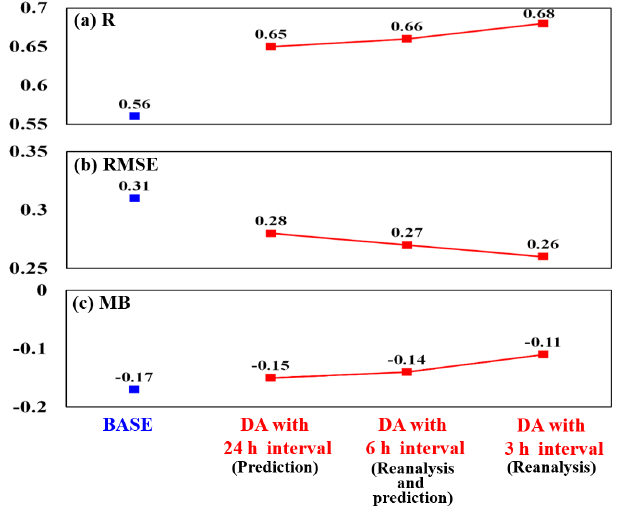
Figure 12. Variations in three performance metrics (R, RMSE and MB) with time intervals of data assimilations. For these tests, the GOCI AODs were used in the DA to update the initial condi- tions of the CMAQ model simulations. The results from the three CMAQ model simulations were compared with AERONET AODs (“ground truth”). The blue squares represent the performances from the BASE RUNs and the red squares indicate the performances from the DA RUNs. The three experiments were carried out with the as- similation time intervals of 24, 6 and 3h, respectively. Here, the DA RUN with the 24h time interval is referred to as “air quality predic- tion”, and the DA RUNs with the 6 and 3h time interval are referred to as “air quality reanalysis”.